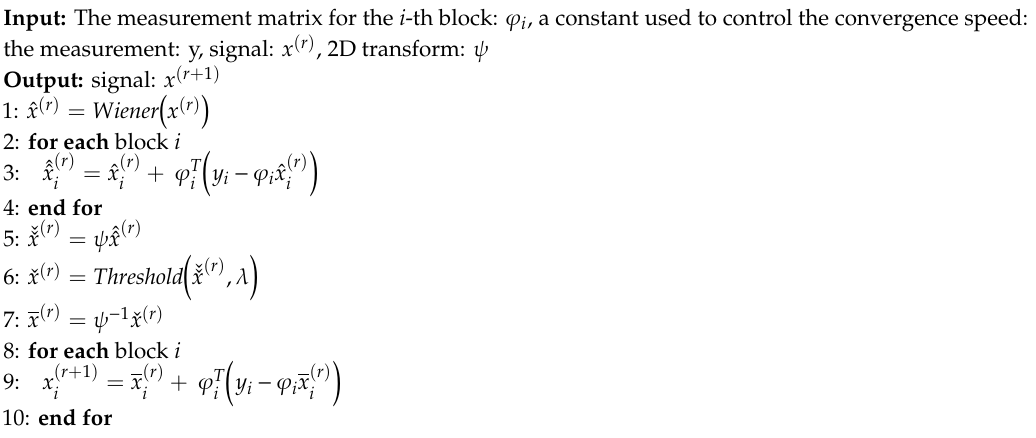
Algorithm 2 BCS-SPL Reconstruction Algorithm